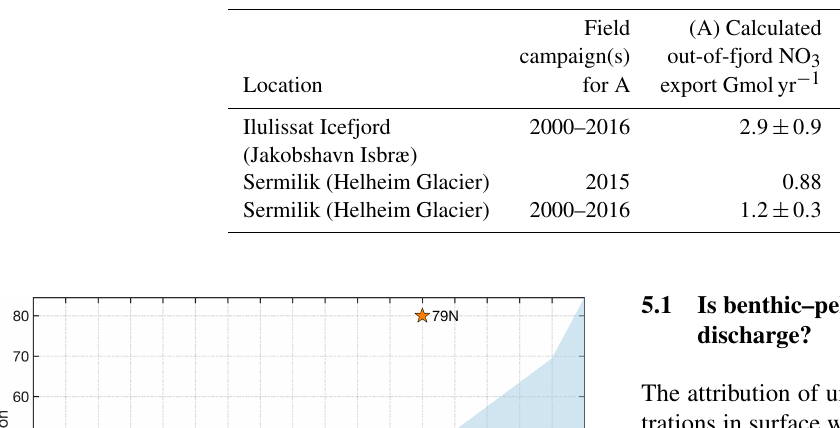
Table 4. A comparison of upwelled NO 3 fluxes calculated from fjord-specific observed nutrient distributions (A) (Cape et al., 2019) and using regional nutrient profiles with idealized plume theory (B) (Hopwood et al., 2018). “A” refers to the out-of-fjord transport of nutrients, whereas “B” refers to the vertical transport close to the glacier terminus.